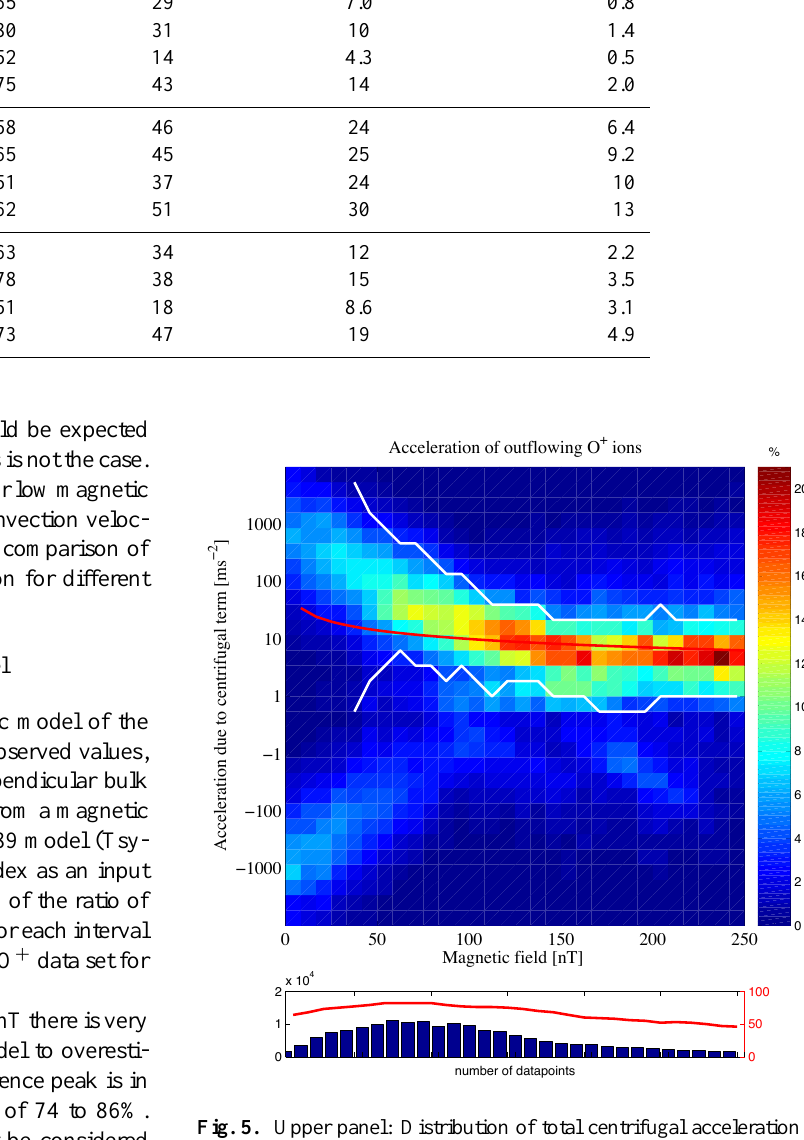
Fig. 5. Upper panel: Distribution of total centrifugal acceleration (positive in direction of outflow) [ms − 2 ] for each interval of magnetic field strength [nT]. Each column is normalized, the sum of all data bins in a column is 100% if all data is within the plotted interval. White lines indicate the narrowest region around the maximum in each column which contains 50% of all data points. Also shown is a red line proportional to one over the square root of B. Lower panel: Number of data points contributing to each column (blue bars, left y-axis), and the number of measurement days contributing to the column (red line, right y-axis).